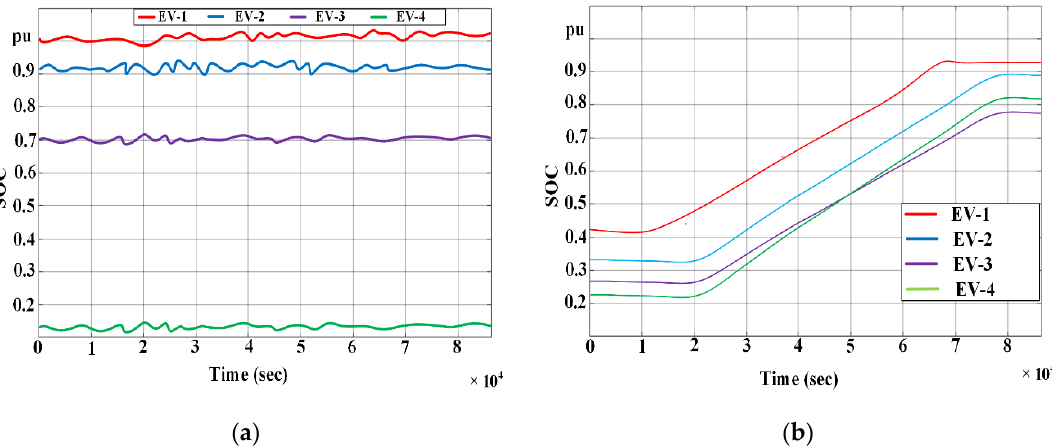
Figure 13. Real-time battery state of charge for the four EVs under consideration for ( a ) TYPE 1, Charging Station 2 and ( b ) TYPE 2, Charging Station 2.